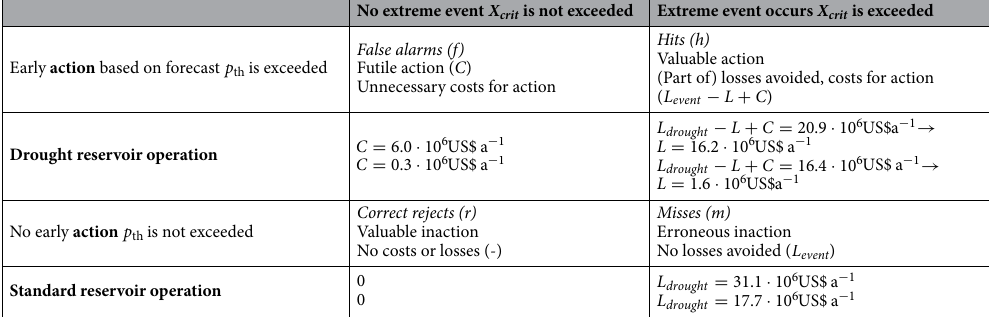
Table 1. Contingency table for forecast-based action. For the four action-event scenarios, the economic consequences are shown. For the case study of drought and standard reservoir operations at the Upper Atbara Dam in Sudan, the costs and losses for different outcomes of the decision model without operation restrictions (upper line of reservoir operations) and with sediment sluicing (lower line of reservoir operations) are provided. The resulting ratio of costs for action ( C ) and avoidable losses ( L ) for a drought operation without restrictions and with sediment sluicing are 0.37 and 0.19,